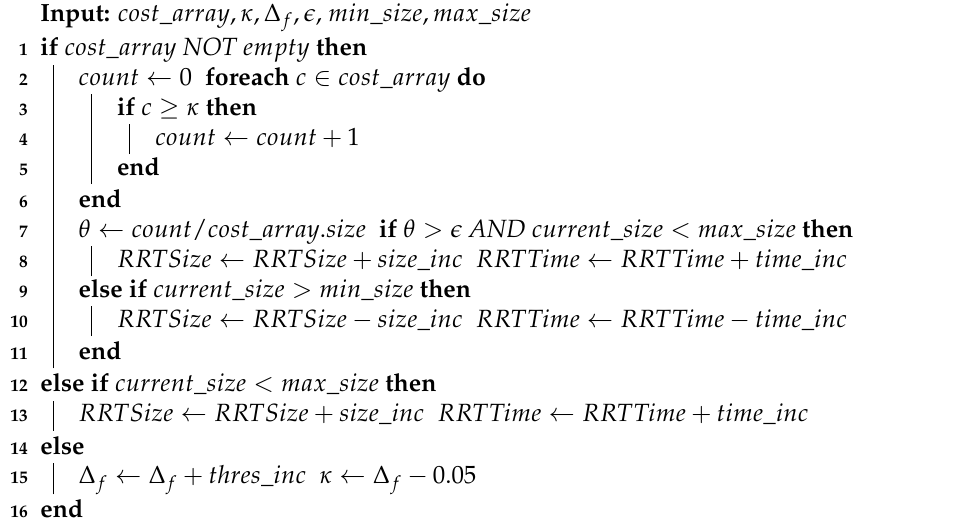
Algorithm 1 Size-and-threshold evaluator